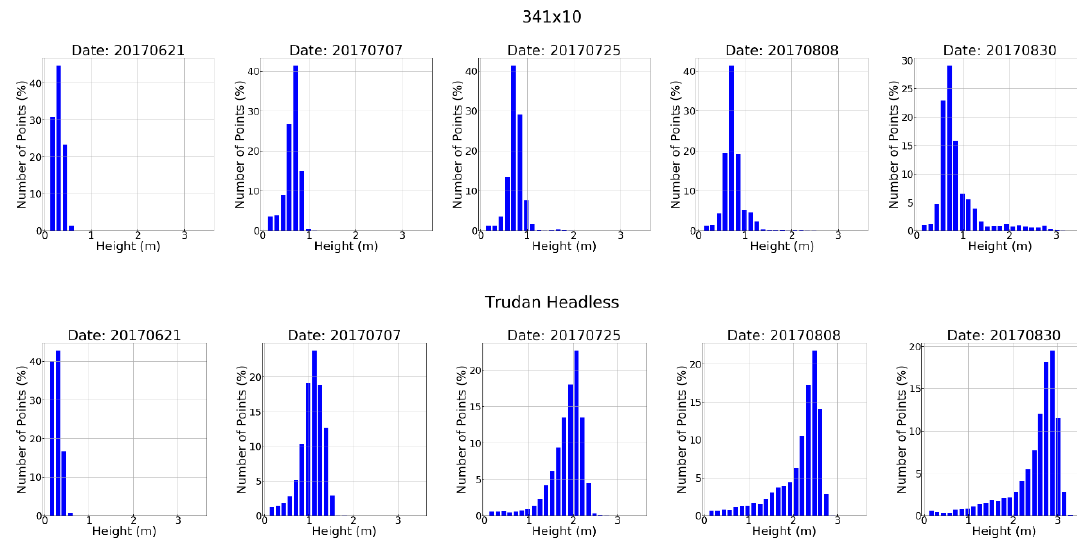
Figure A3. Height histogram for “341 × 10” and “Trudan Headless” in the HyCal panel across the 2017 growing season.